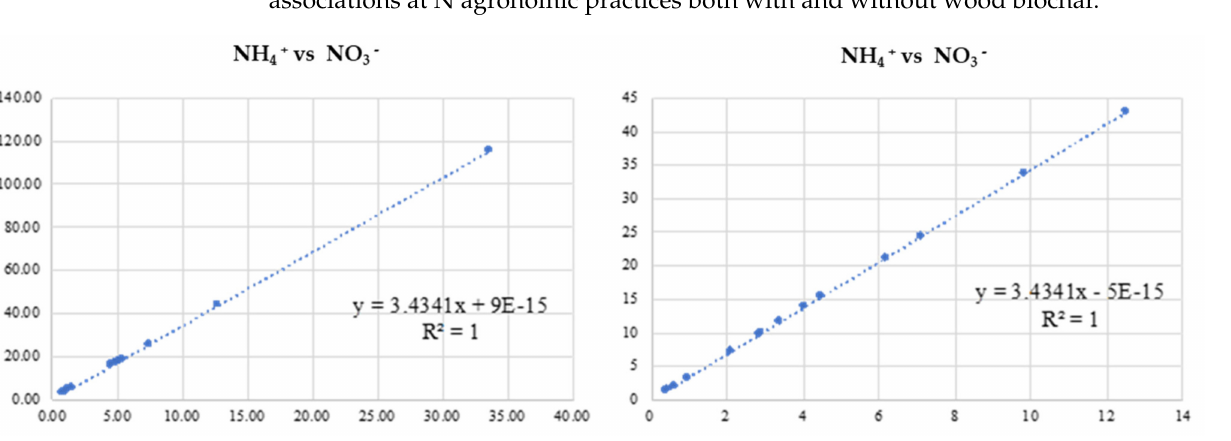
Figure 3. Relationship between nitrogen compounds (mg/L) in water-leached samples after the first N fertilizing practice ( on the left ), and the second N fertilizing practice ( on the right